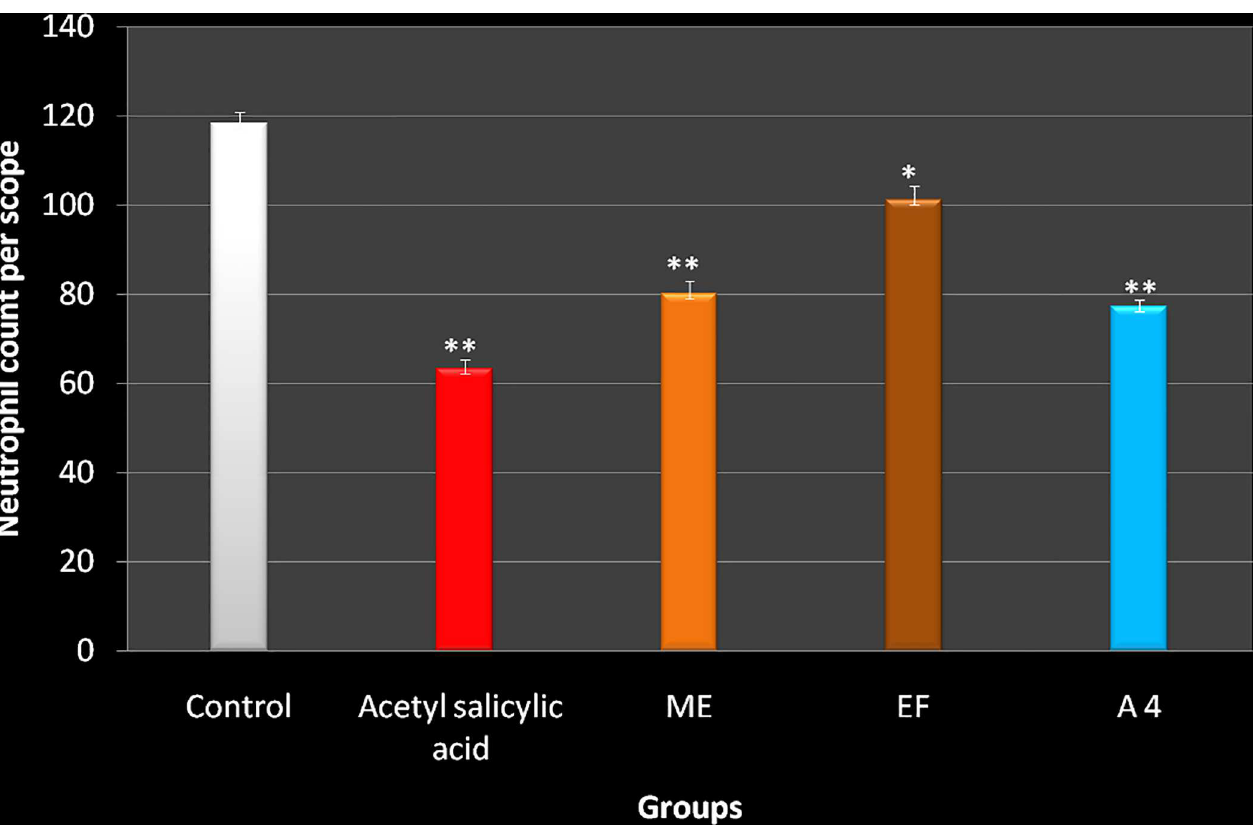
Fig 3. Effect of M . philippensis leaves on neutrophil infiltration in rat paw after carrageenan injection. Values are expressedas Mean ± S.E.M. * indicatesp < 0.05, ** indicatesp < 0.001when comparedto the control group Aspirin-100mg/kg, Normal Control- Normal saline1ml/kg, ME-Methanol extract 500mg/kg, EF-Ethylacetate fraction 500 mg/kg, A 4– Active compoundof M . philippensis